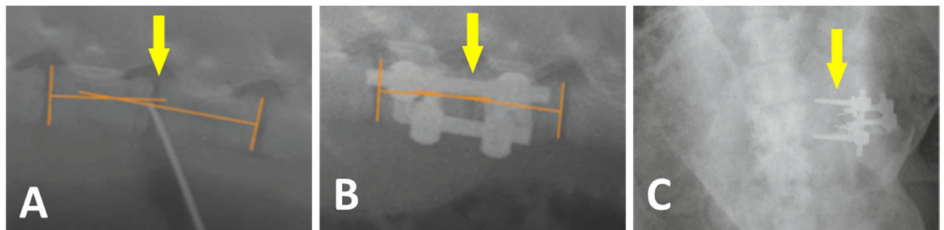
Figure 6. Plain X-ray radiographs of lateral views taken before ( A ) and after the surgery ( B ) Yellow arrows show the L2/L3 segment of implantation. Loosening and migration of the screws of the A2 group in 4 weeks after surgery. Plain X-ray radiographs of the antero-posterior view ( C